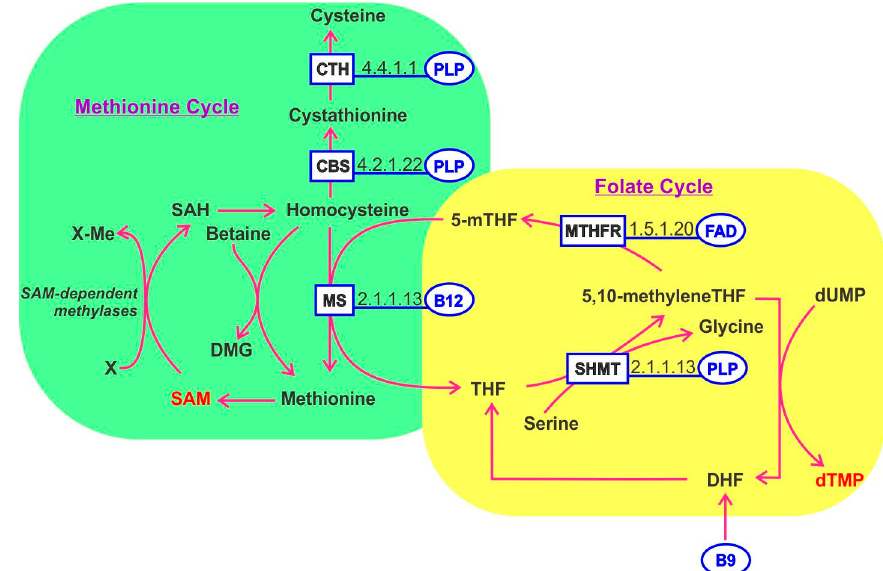
Figure 3. The methionine and folate cycle pathways involving PLP-, FAD- and B12-dependent enzymes. The folate cycle begins with the conversion of dietary folate (B9) into dihydrofolate (DHF), which is then reduced to tetrahydrofolate (THF) by the enzyme dihydrofolate reductase (DHFR). THF is next converted to 5,10-methyleneTHF by serine hydroxymethyltransferase (SHMT), a reaction that is coupled with the hydroxylation of serine (Ser) to glycine (Gly) and requires PLP as a cofactor. Thymidylate synthase (TS) uses 5,10-methyleneTHF as a methyl donor to methylate deoxyuridine monophosphate (dUMP), creating deoxythymidine monophosphate (dTMP). This step regenerates DHF for continued cycling. Alternatively, 5,10-methyleneTHF can be reduced by methylenetetrahydrofolate reductase (MTHFR) to 5-methytetrahydrofolate (5-mTHF) using FAD as a cofactor. As part of the methionine cycle, 5-mTHF donates a methyl group to regenerate methionine from homocysteine (Hcy), which is catalyzed by methionine synthase (MS) that requires B12, in the form of methylcobalamin, as a cofactor. To generate the methyl donor S -adenosylmethionine (SAM) for use by multiple methyltransferases. SAM is demethylated during the methyltransferase reactions to form S -adenosylhomocysteine (SAH) which is then hydrolysed by S -adenosylhomocysteine hydrolase (AHCY) to form Hcy. Hcy can also enter the trans-sulfuration pathway catalyzed by cystathionine beta synthase (CBS) and cystathionine gamma lyase (CTH), both requiring PLP as a cofactor, to create cysteine.